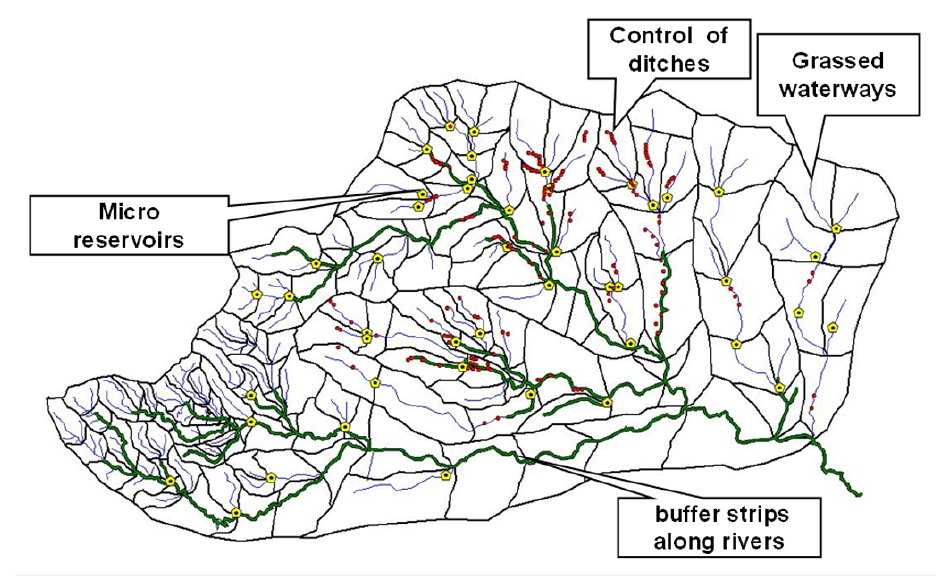
Fig. 2. Proposal of Hydraulic arrangements for La Colacha basin. WM (water management), mainly to control erosions.